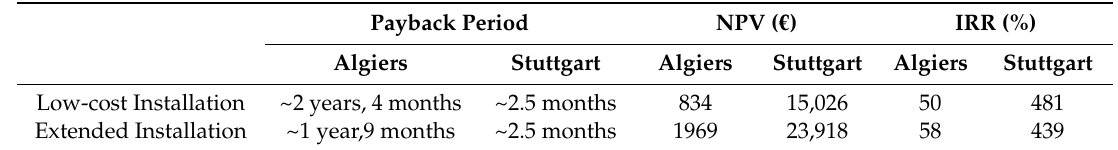
Table 6. Summary of economic indicators.